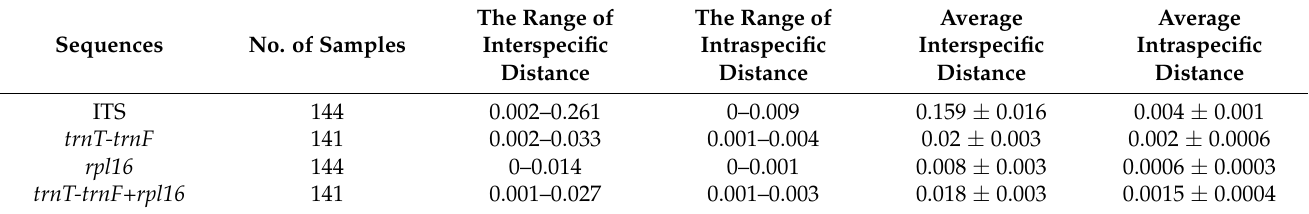
Table 2. Parameters of the interspecific and intraspecific variations of each DNA barcoding.